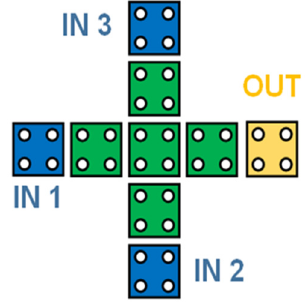
Figure 3. QCA majority voter gate